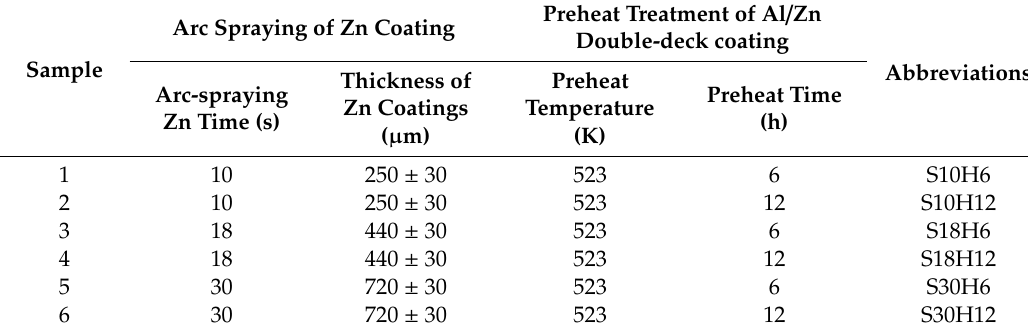
Table 3. Process parameters of the arc-spraying of the Zn coating and preheat treatment of the Al / Zn double-deck